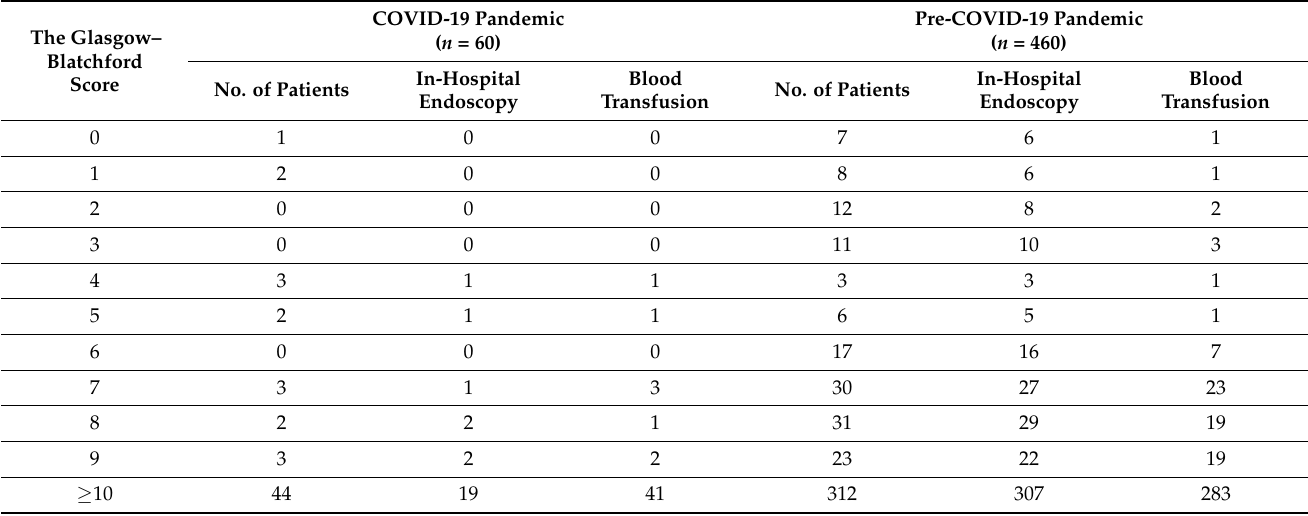
Table 5. The need for endoscopy and blood transfusion among the overall population according to the Glasgow–Blatchford score.